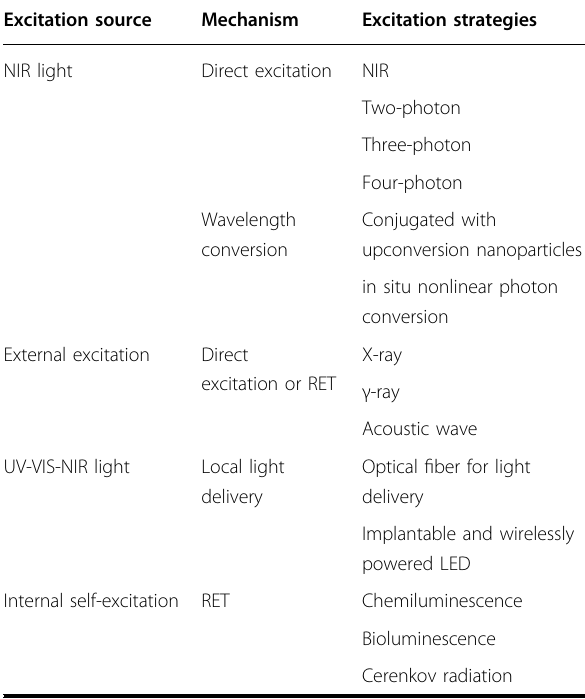
Table 1 Excitation sources for deep PDT Excitation